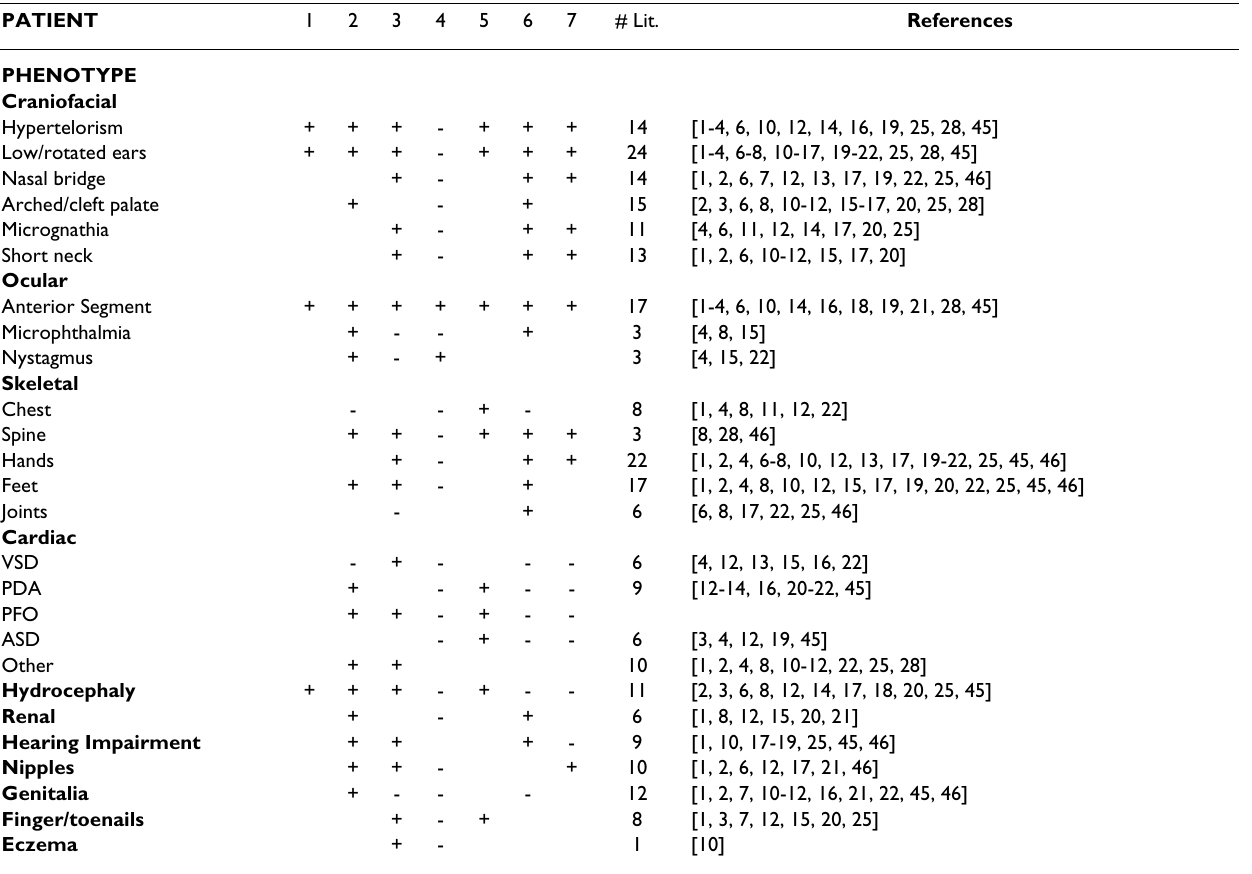
Table 1: Clinical features of deletion patients in this study and a survey of the literature.